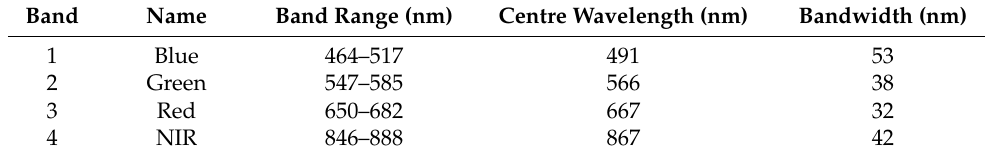
Table 3. Spectral characteristics of the PlanetScope Dove-R sensors.